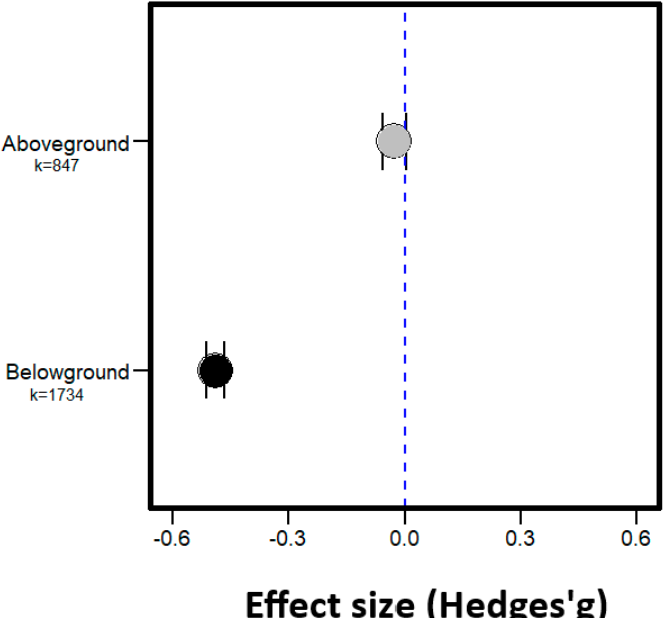
Figure 5. Effects of fire on aboveground and belowground fauna. Circles denote the Hedges’ g value and lines denote the 95% confidence intervals (CI) for each Hedges’ g value. Black circles are significant effects whilst grey circles show no significant effects.